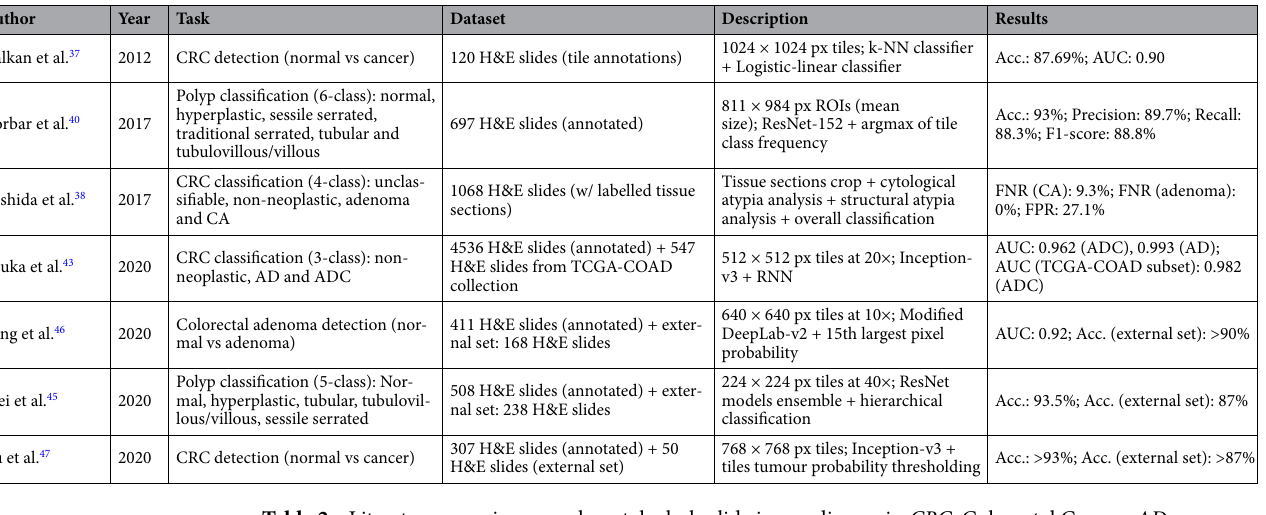
Table 2. Literature overview on colorectal whole slide image diagnosis. CRC : Colorectal Cancer; AD : Adenoma; CA : Carcinoma; ADC : Adenocarcinoma; H&E : Haemotoxylin & Eosin; px : pixels; k-NN : k